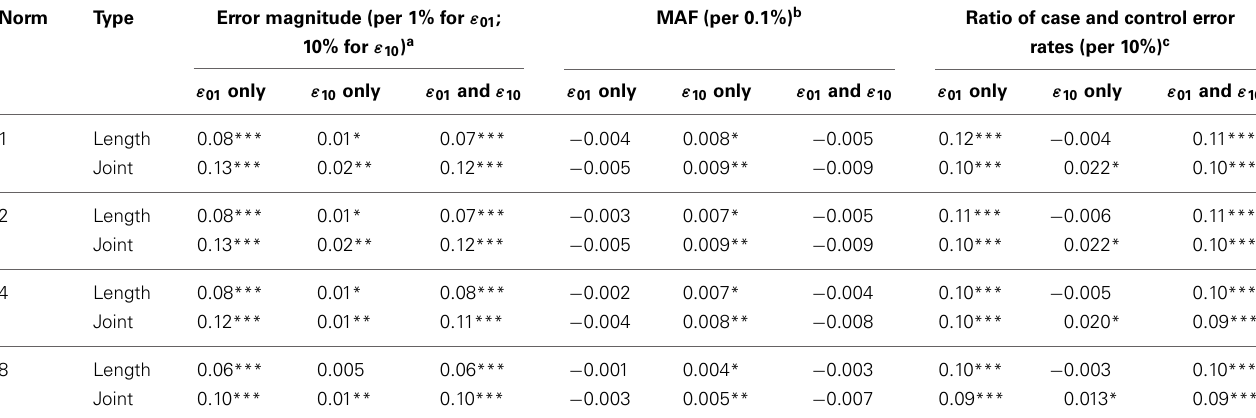
Table 2 | Regression model coefficients relating type I error loss/gain to simulation